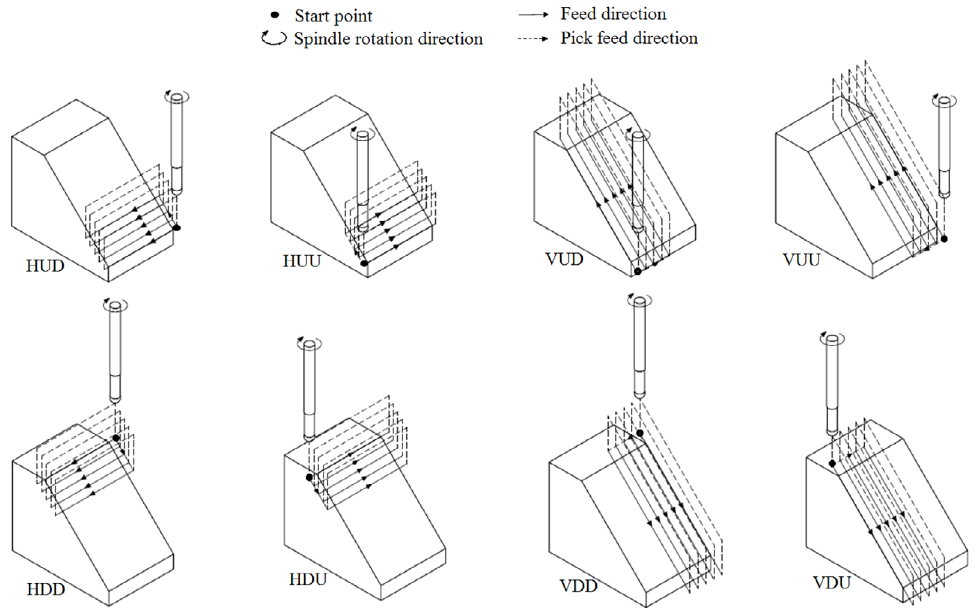
Figure 1. Tool path